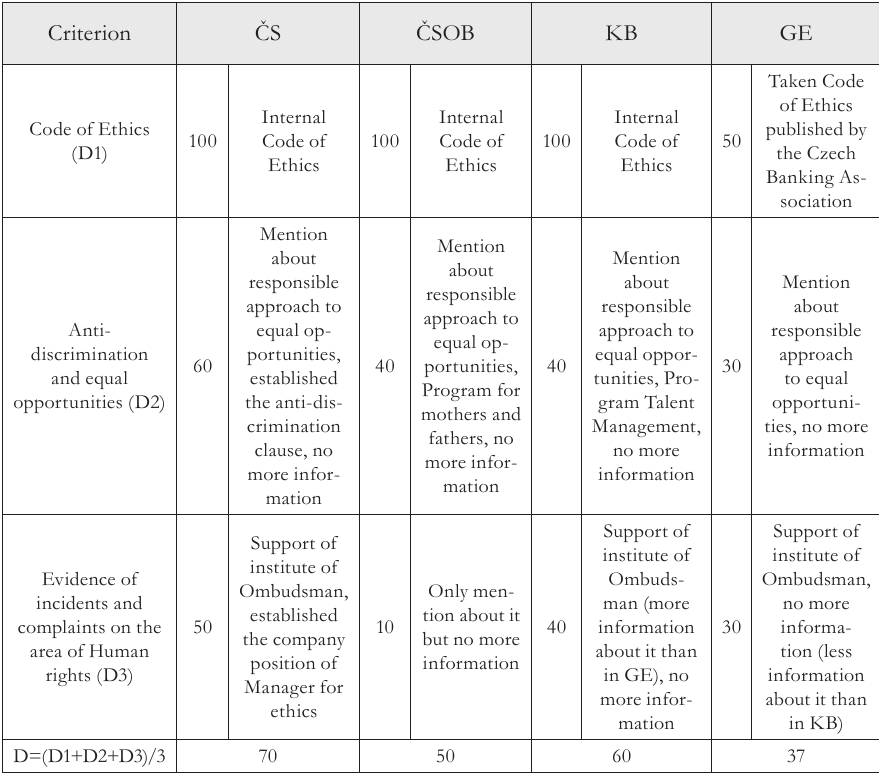
Tab. 4 - Evaluation criteria in the area of the Human rights. Source: